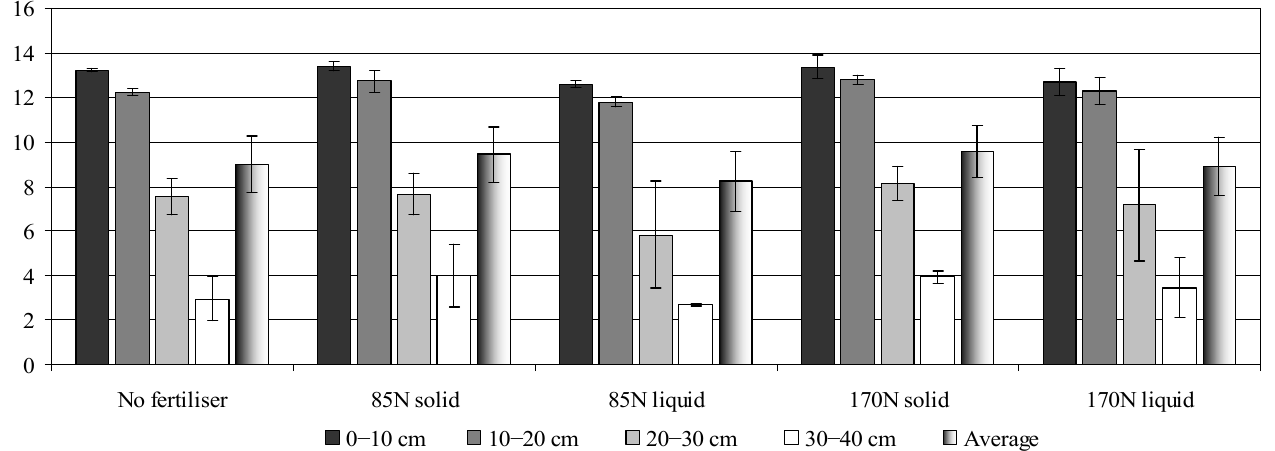
Figure 3. SOC content in the crop rotation field in Fluvisol, 2020 .